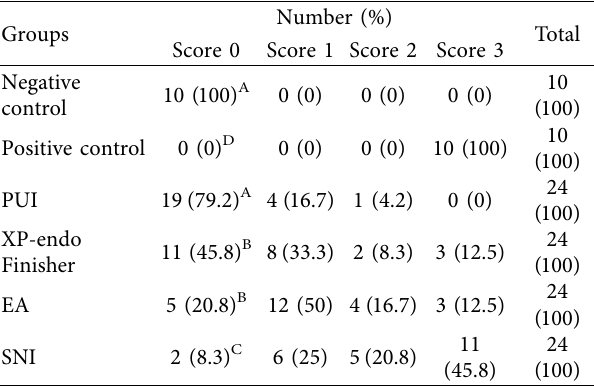
Different uppercase letters show significant difference between groups (in a